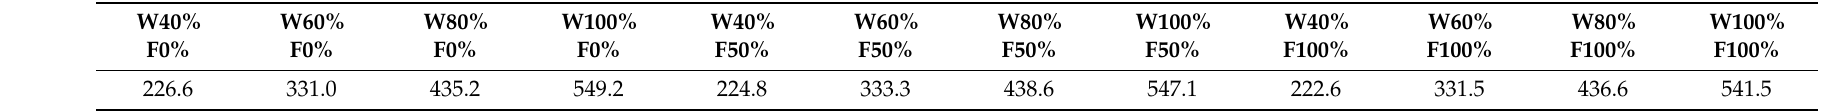
Table 2. Actual cumulative irrigation (mm) according to the irrigation and fertigation regime.